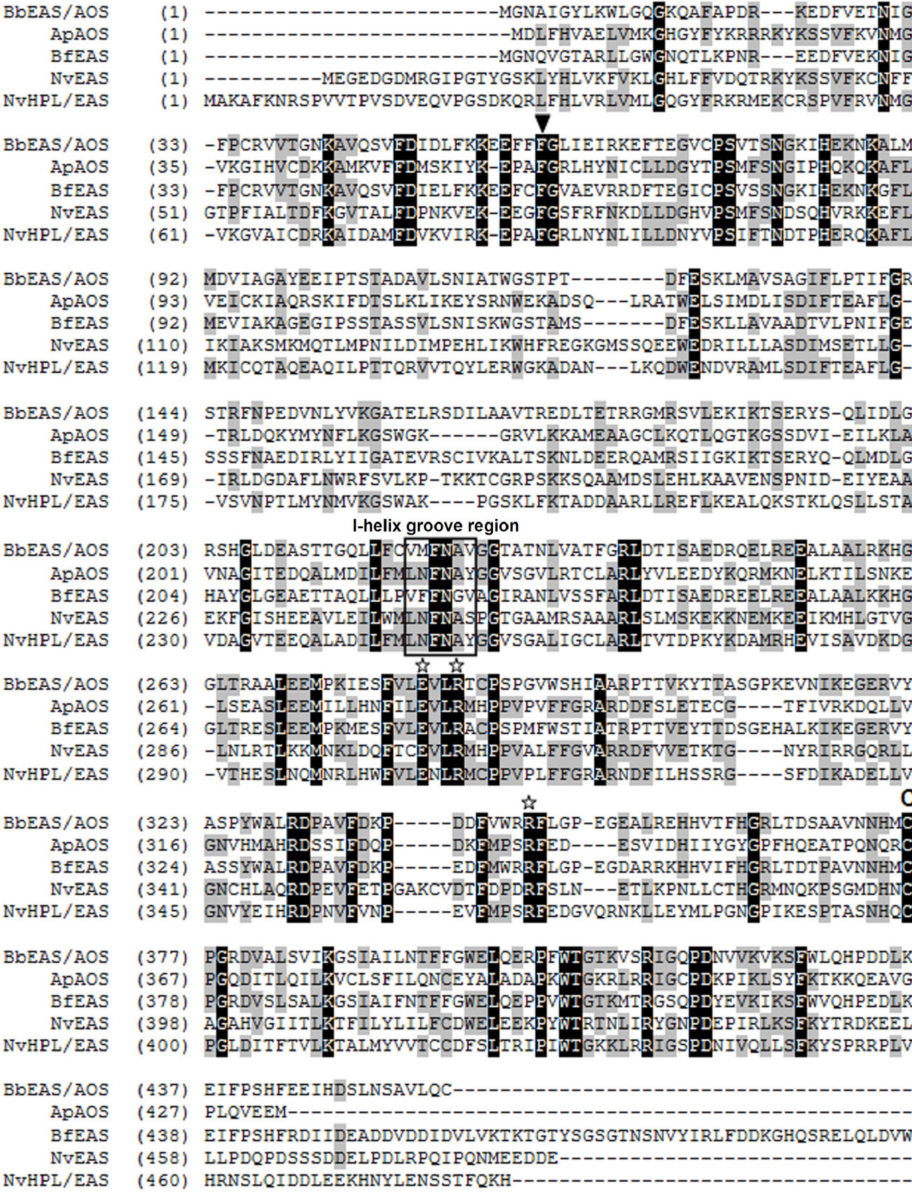
Figure 1. The multiple alignment of the CYP440A18 sequence with sequences of metazoan CYP74 clan members characterized earlier: Ap, Acropora palmata (coral); ApAOS, ACD42778.1; Bf, Branchiostoma floridae ; BfEAS, ACD88492.1; Nv, Nematostella vectensis ; NvEAS, XP_001636360.1; NvHPL/EAS, QJI54761.1. Conservative structures are marked as follows: the I-helix groove region is signed, while the F/L toggle, the ERR-triad, and the cysteinyl ligand are marked by triangle, stars, and C,